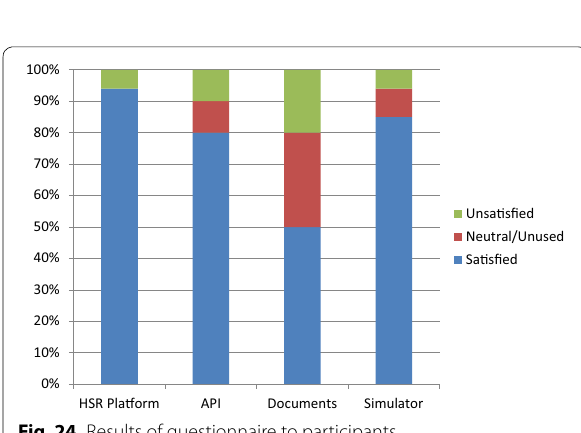
Fig. 24 Results of questionnaire to participants